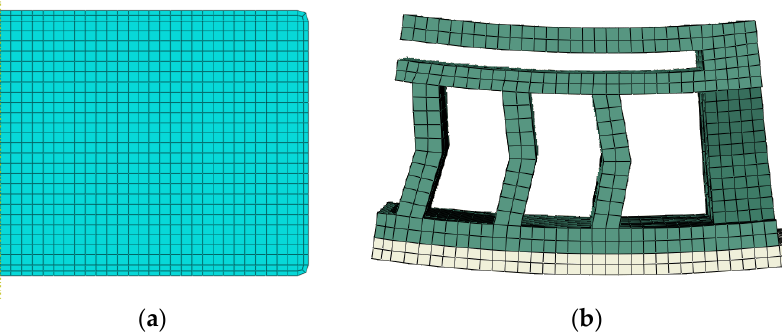
Figure 8. Numerical model of rubber samples. ( a ) Rubber materials, ( b ) rubber device.